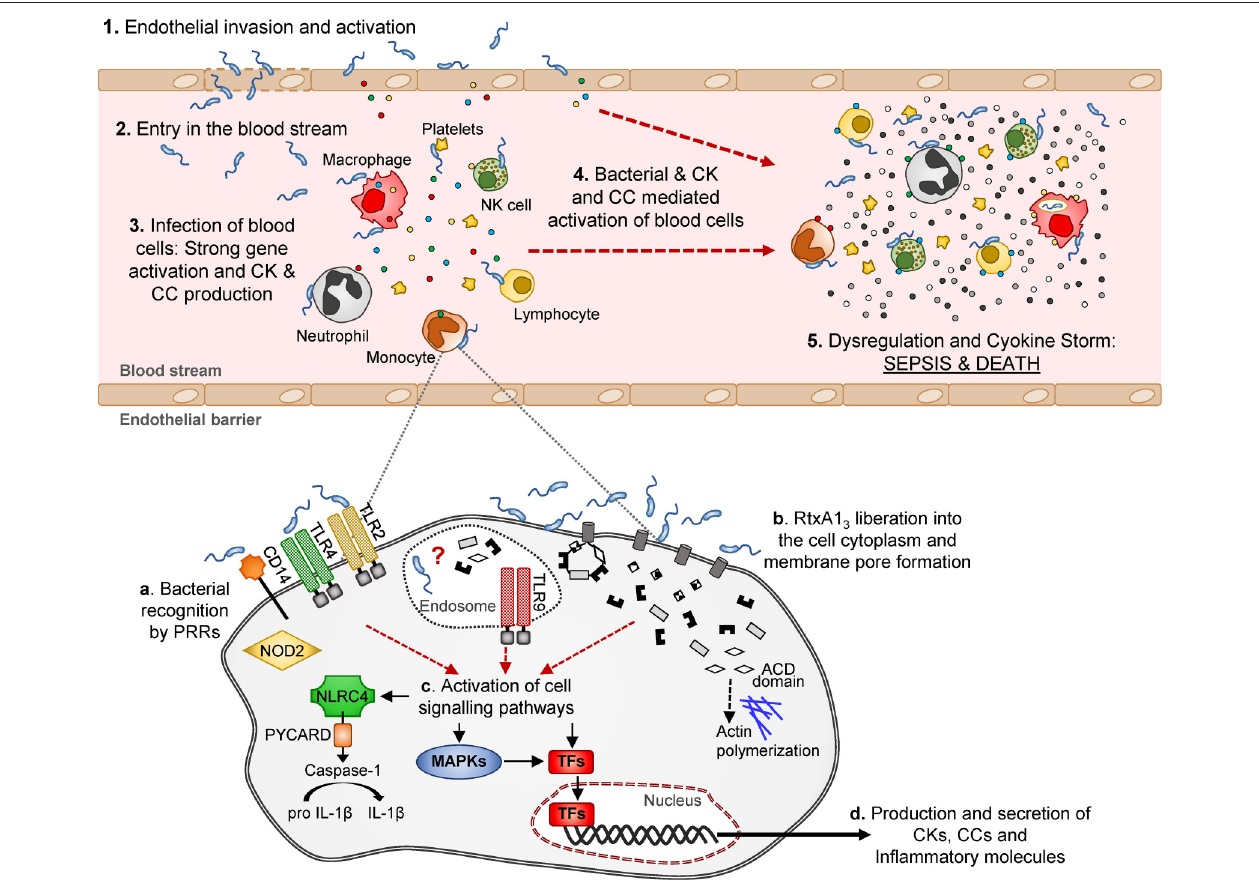
FIGURE 10 | Schematic model of V. vulnificus Bt2-SerE induced sepsis. V. vulnificus Bt2-SerE would cause sepsis only in patients with high iron levels in blood, and according to the following model: (1) the bacterial cells would reach the endothelial microvasculature from the infection site. There, they will infect the endothelial